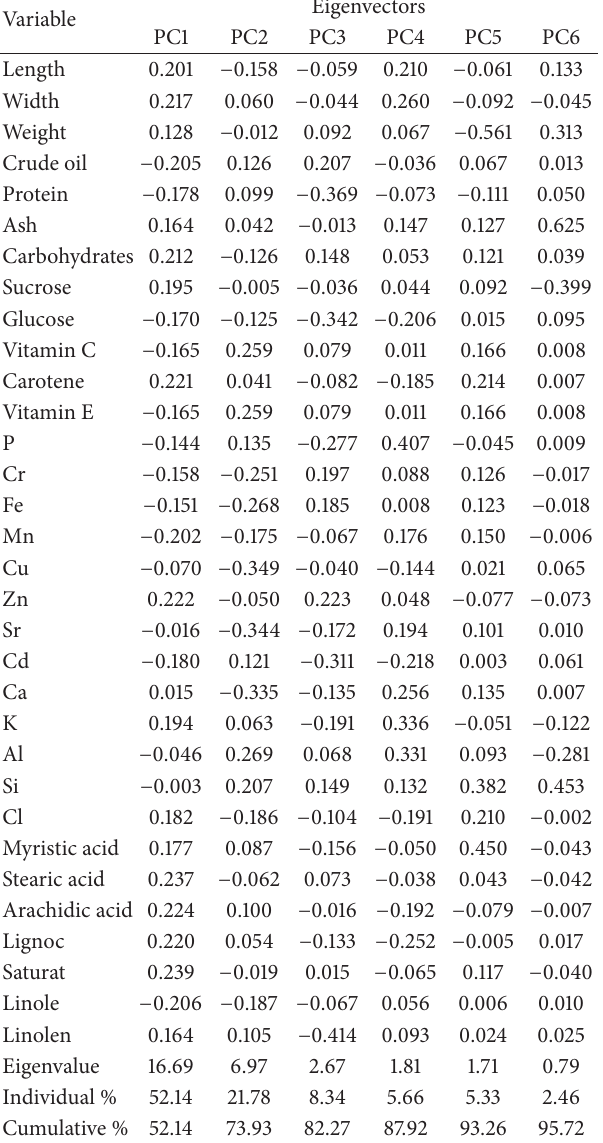
Table 6: Eigenvectors and percent explained variation by the first six principal components of physical and chemical data parameters of 3 morphotypes of Cyperus esculentus